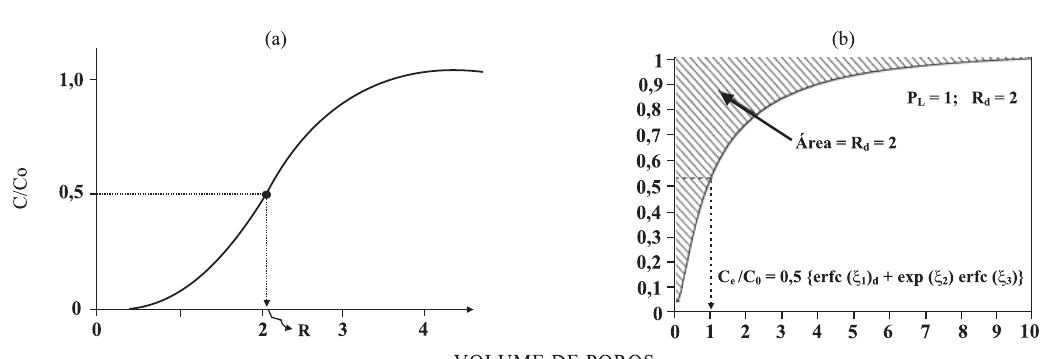
Figura 2. Determinação do fator de retardamento (R), para Pe > 50 (a) e Pe < 50 (b) (Shackelford,